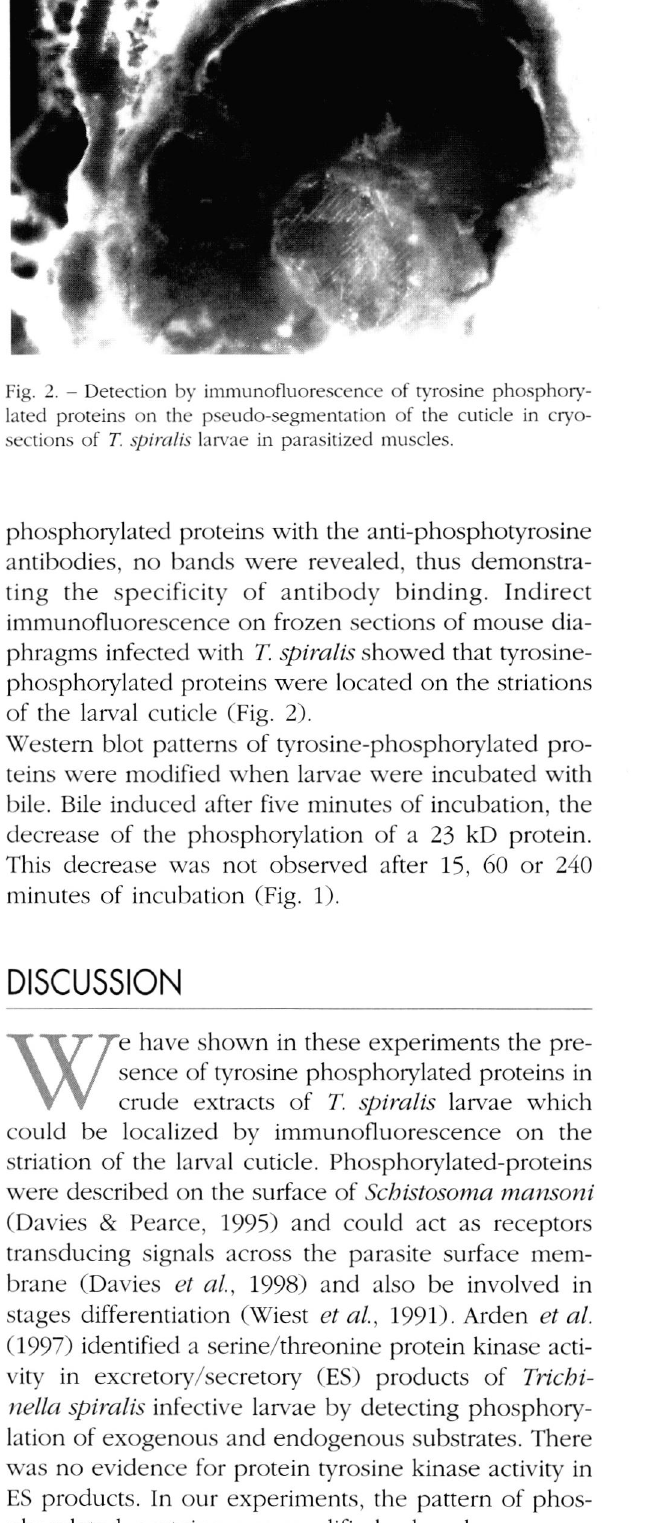
Fig. 1. - Analysis of Trichinella spiralis antigens by anti-phospho tyrosine antibody 1G2. with and without bile: lane 1: molecular weight marker; lane 2: Jurkat cells crude extract (postive control); lane 3: extracts of larvae incubated in bile for four hours; lane 4: extracts of larvae incubated in bile for one hour; lane 5: extracts of larvae incubated in bile for 15 minutes; lane 6: extracts of larvae incubated in bile for five minutes; lane 7: Trichinella crude extract: lane 8: E.coli crude extract (negative control).